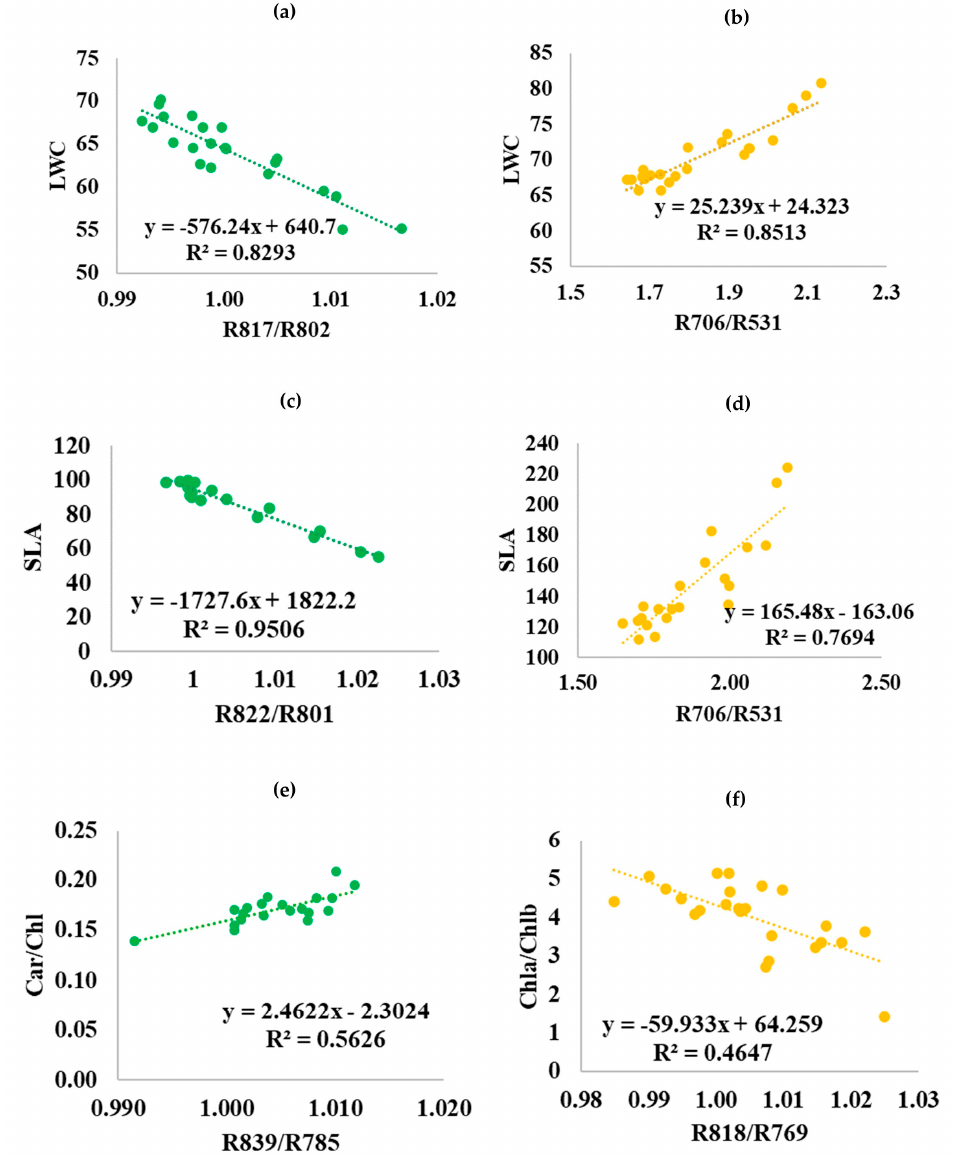
Figure 9. Simple linear regression (SLR) for the most-significant functional optical properties and simple ratios (SR). Regressions are performed for the target invasive species Psidium guajava (PG, green = ( a – c )) and Hovenia dulcis (HD, yellow = ( d – f )). LWC (%) = liquid water content; SLA (cm².g − 1 ) = specific leaf area; Chla/Chlb = chlorophyll a:b ratio; Car/Chl = carotenoid:total chlorophyll ratio. Significant results at α = 0.01, and at a 99% confidence level ( p -value < 0.01).